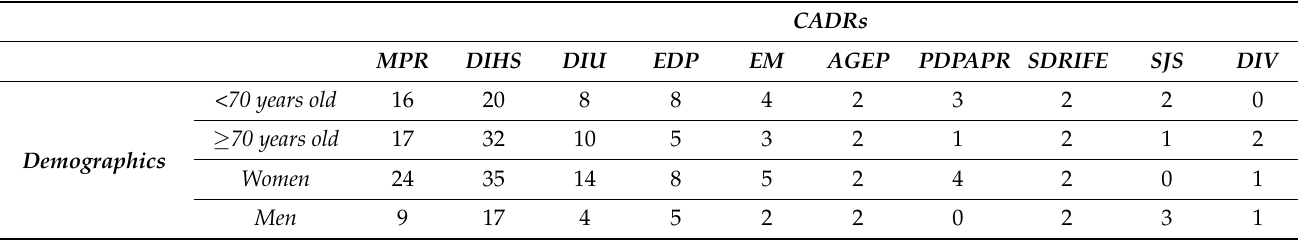
Table 2. Characteristics of the study population—Number of people.